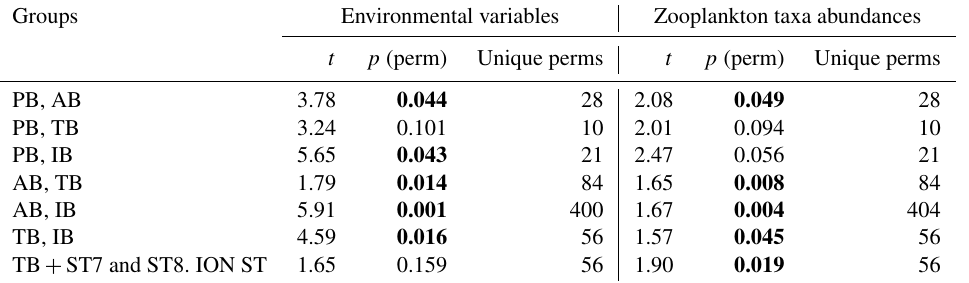
Table 5. PERMANOVA analysis on the environmental variables and on zooplankton taxa abundances: pair-wise tests with unrestricted permutation of raw data (number of permutations: 999) were used for the comparison between the zones. Resemblance worksheets are based on Euclidean distance. Significant p values ( p < 0 . 05) are marked in bold. Groups Environmental